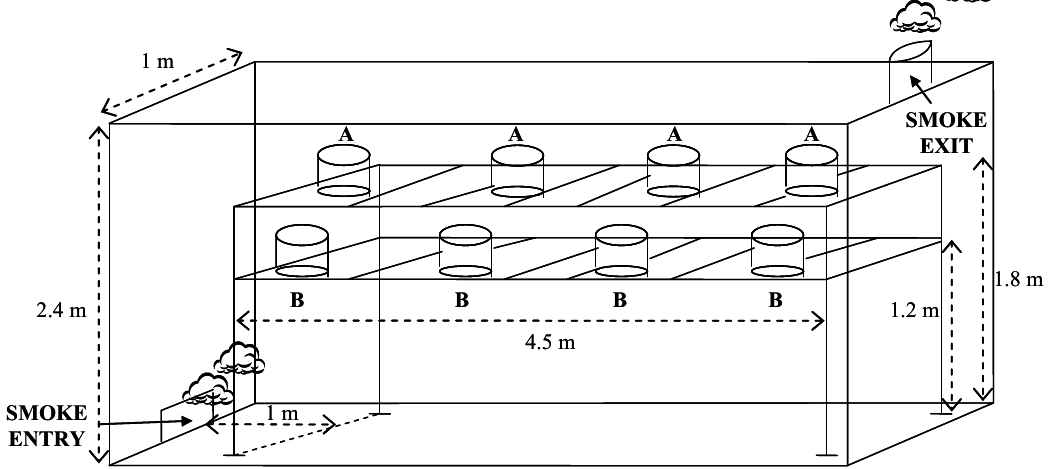
Figure 2. Scheme of the position of the A and B Herreño cheeses in the smokehouse.